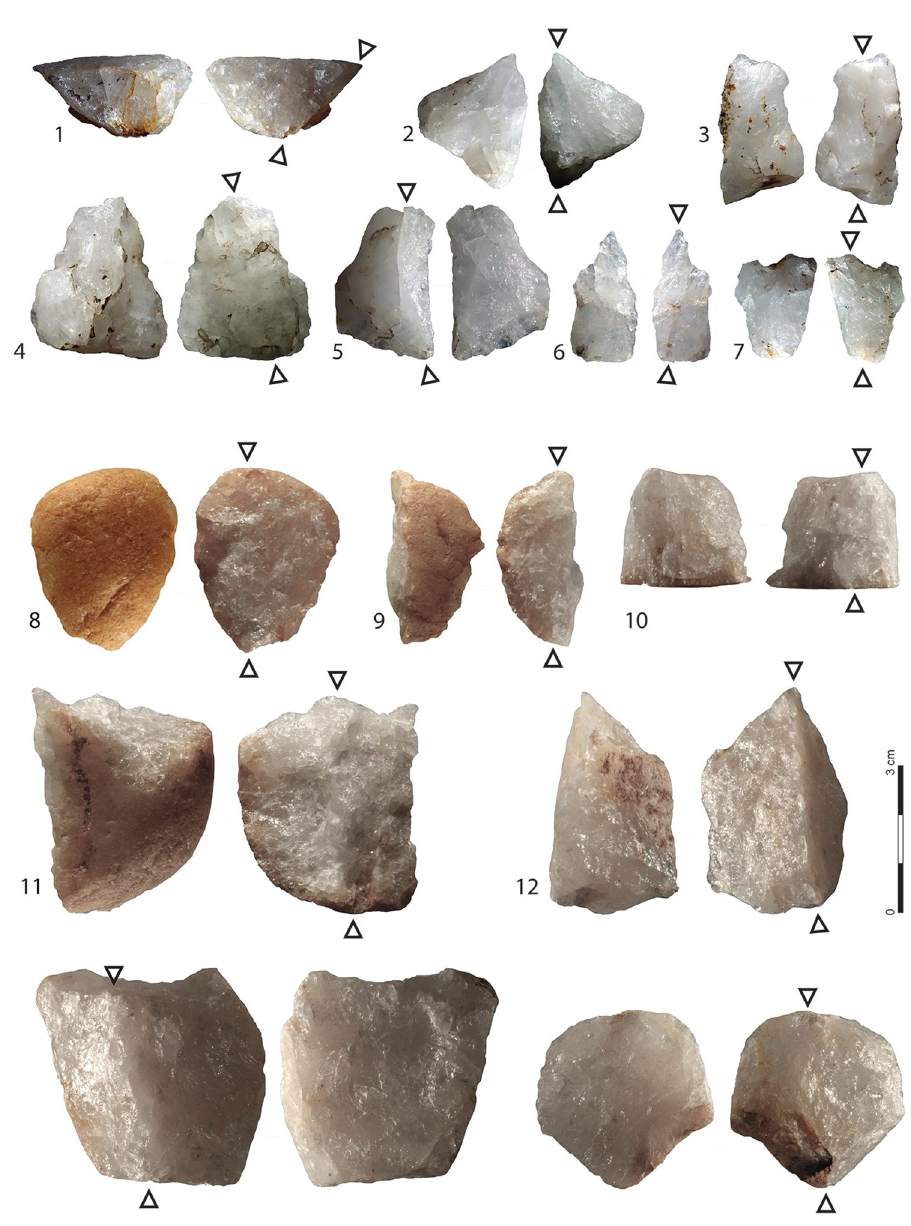
Fig 3. Archaeological and experimental diagnostic bipolar flakes. 1 to 7: archaeological bipolar flakes from OMO 371N –A167; 8 to 12: experimental bipolar flakes. The black triangles indicate the impact points.